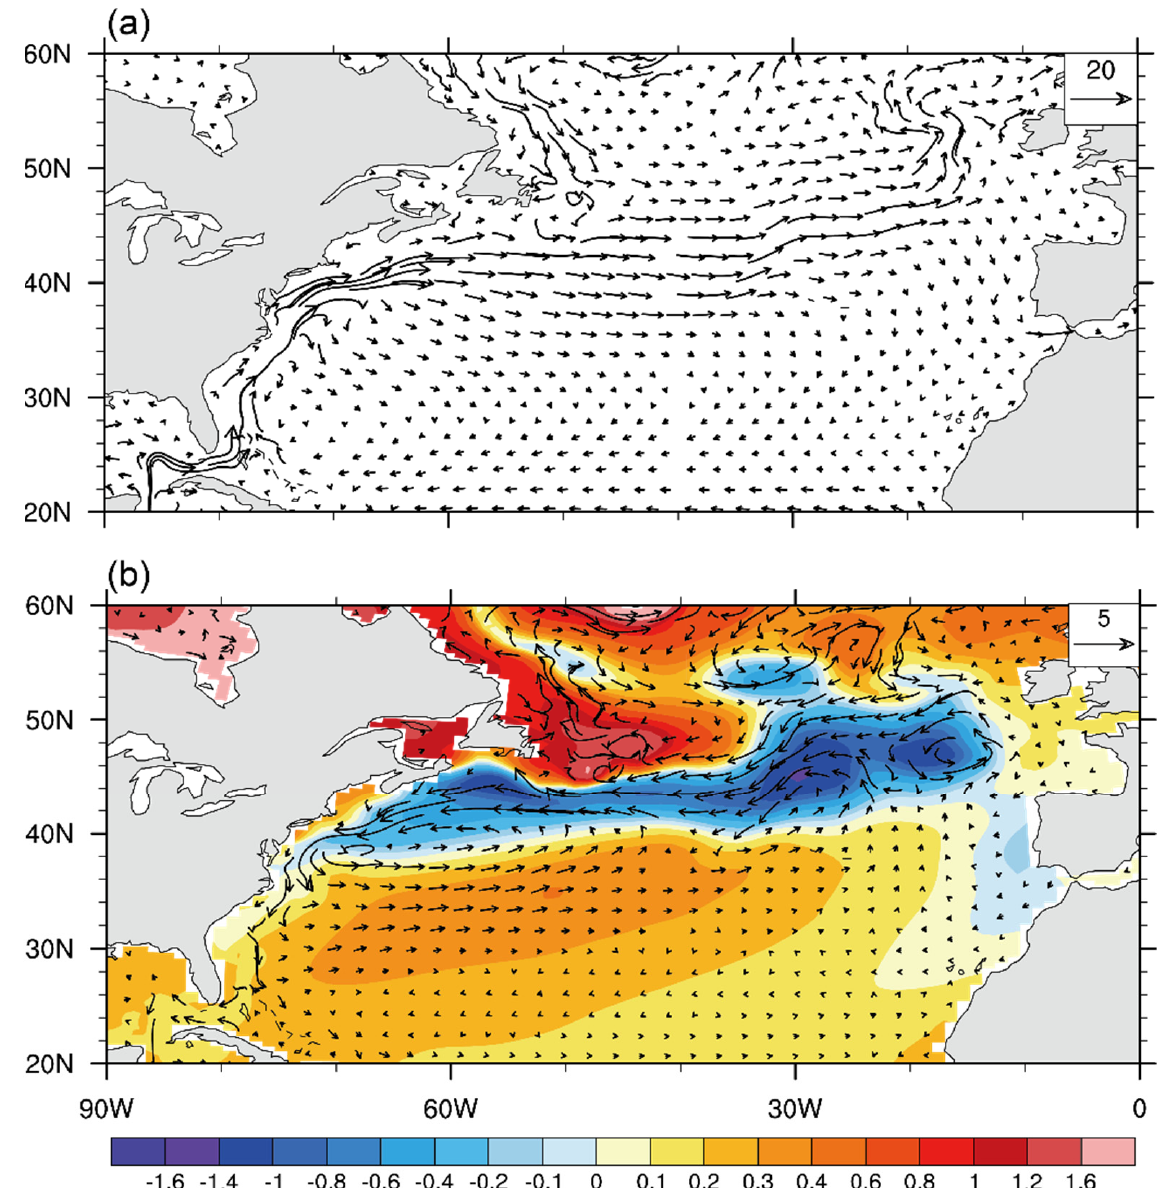
Figure 3. ( a ) Climatological ocean currents averaged in the upper 100 m depth of the North Atlantic in FOM. ( b ) The quasi-equilibrium responses of ocean currents averaged in the upper 100 m depth (vectors, cm/s) and SST (color shading, ℃ ) to Arctic sea ice loss in FOM.